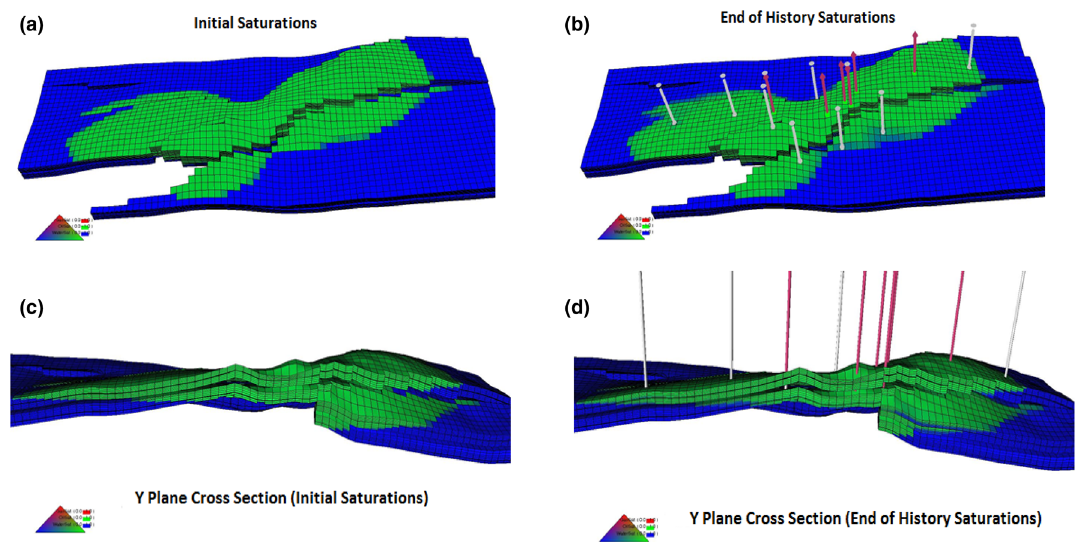
Fig. 5 ‎ a Initial fluid saturations, b end history fluid saturations, c cross section along the Y -plane with initial saturations, and d cross section along the Y -plane with the end of history saturations